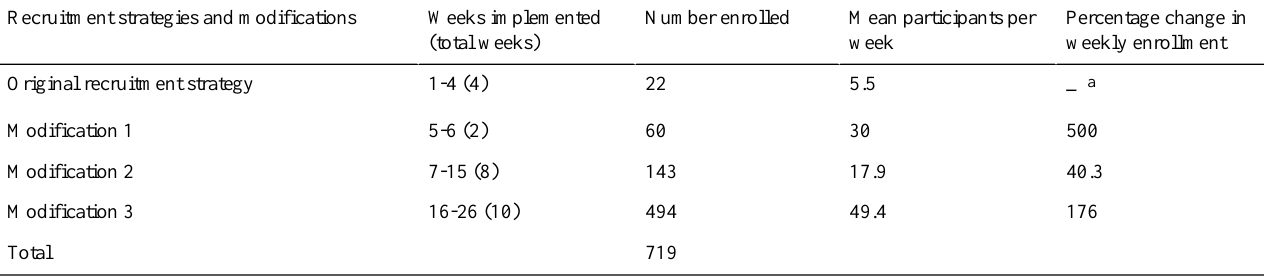
Table 1. Percentage change in enrollment by modification.